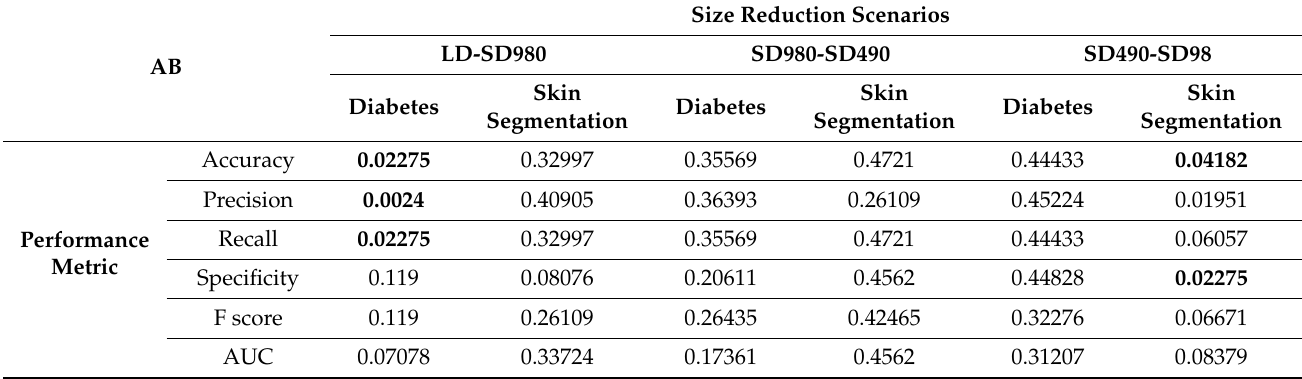
Table A10. p -values for different size reduction scenarios using the AB model; bold values are